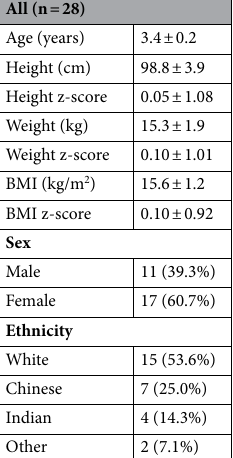
Table 2. Mean ± SD total body less head (TBLH) body composition values from 3.5-year-old children (n = 28) each measured using combinations of two dual-energy X-ray absorptiometry (DXA) devices and two software versions: iDXA scan, Prodigy scan analysed with basic analysis; and Prodigy scan analysed with enhanced analysis. %BF body fat percentage, BMC bone mineral content, BMD bone mineral density, FFM fat-free mass. a Percentage difference (95% CI) in body composition values in reference to the values obtained from the GE Lunar iDXA.